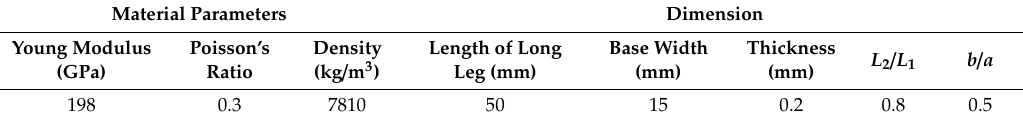
Table 1. Parameters for finite element analysis (FEA) simulation.